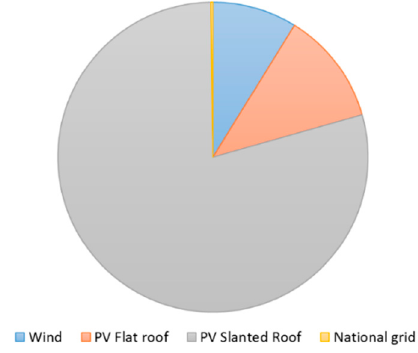
Figure 1. Energy production share for the cost minimization optimal solution.